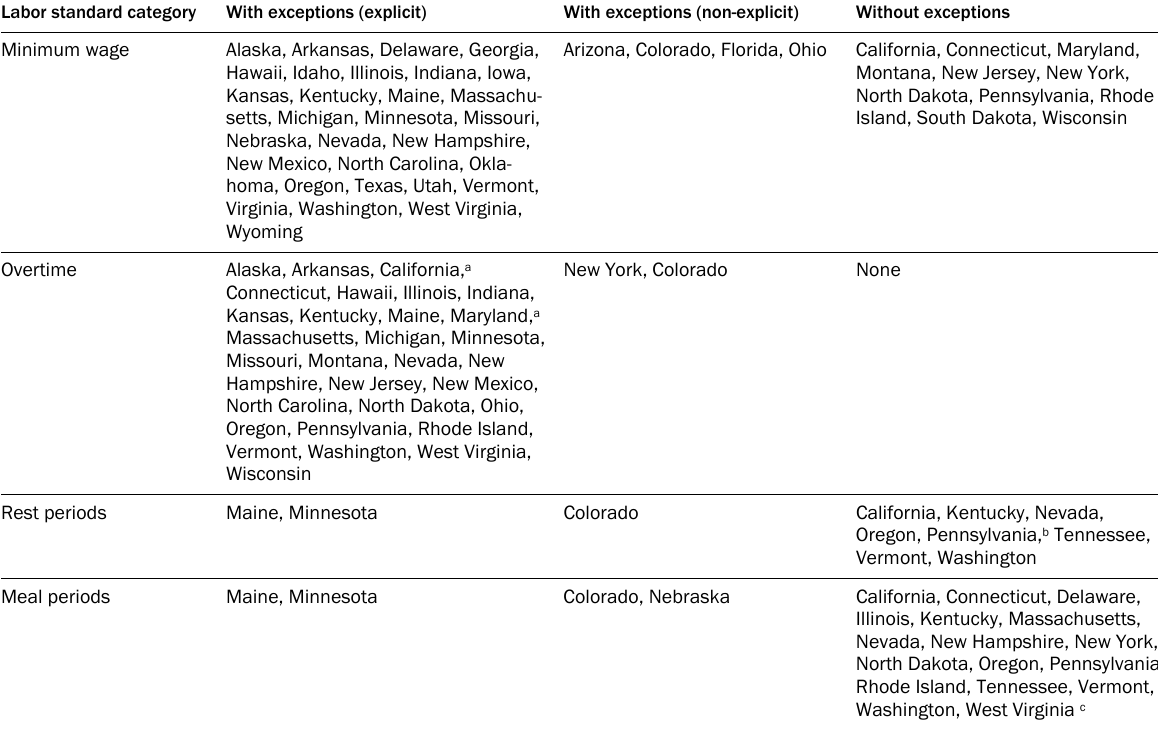
Table 3. States with Their Own Labor Standards, With and Without Exceptions for Farmworkers, by Category of